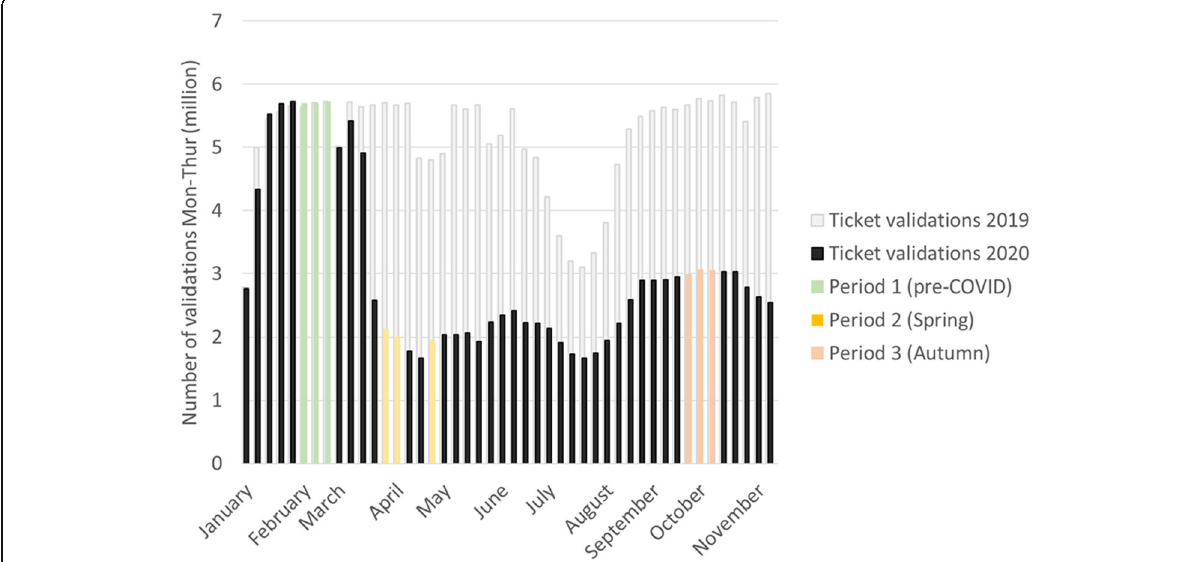
Fig. 1 Number of validations per week (Monday – Thursday) and description of the three chosen periods featured in the paper. For context, ticket validations for 2019 (grey) and 2020 (black) are featured. Period 1 (yellow) is used as a reference period while period 2 (pink) evaluates the effects during spring and period 3 (blue) the effects during autumn. Period 2 is divided into two due to the Easter holiday occurring